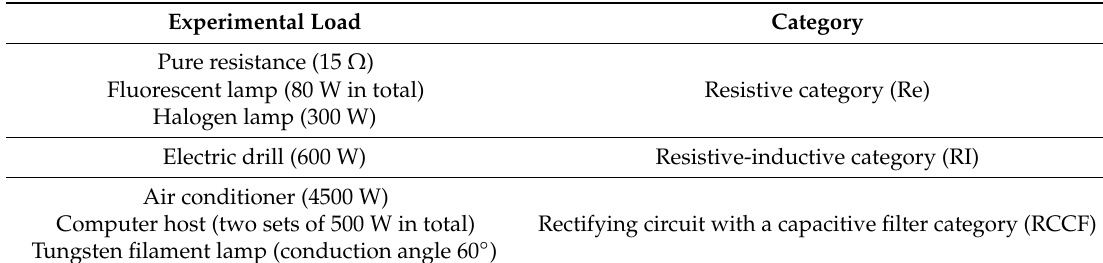
Table 5. Experimental loads and their categories.